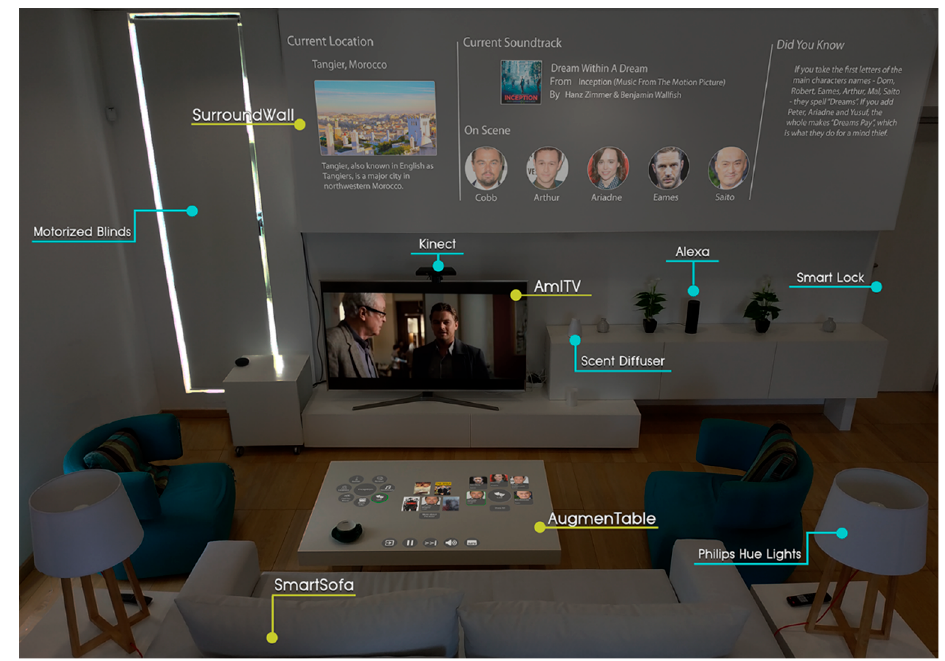
Figure 2. The “Intelligent Living Room” setup.